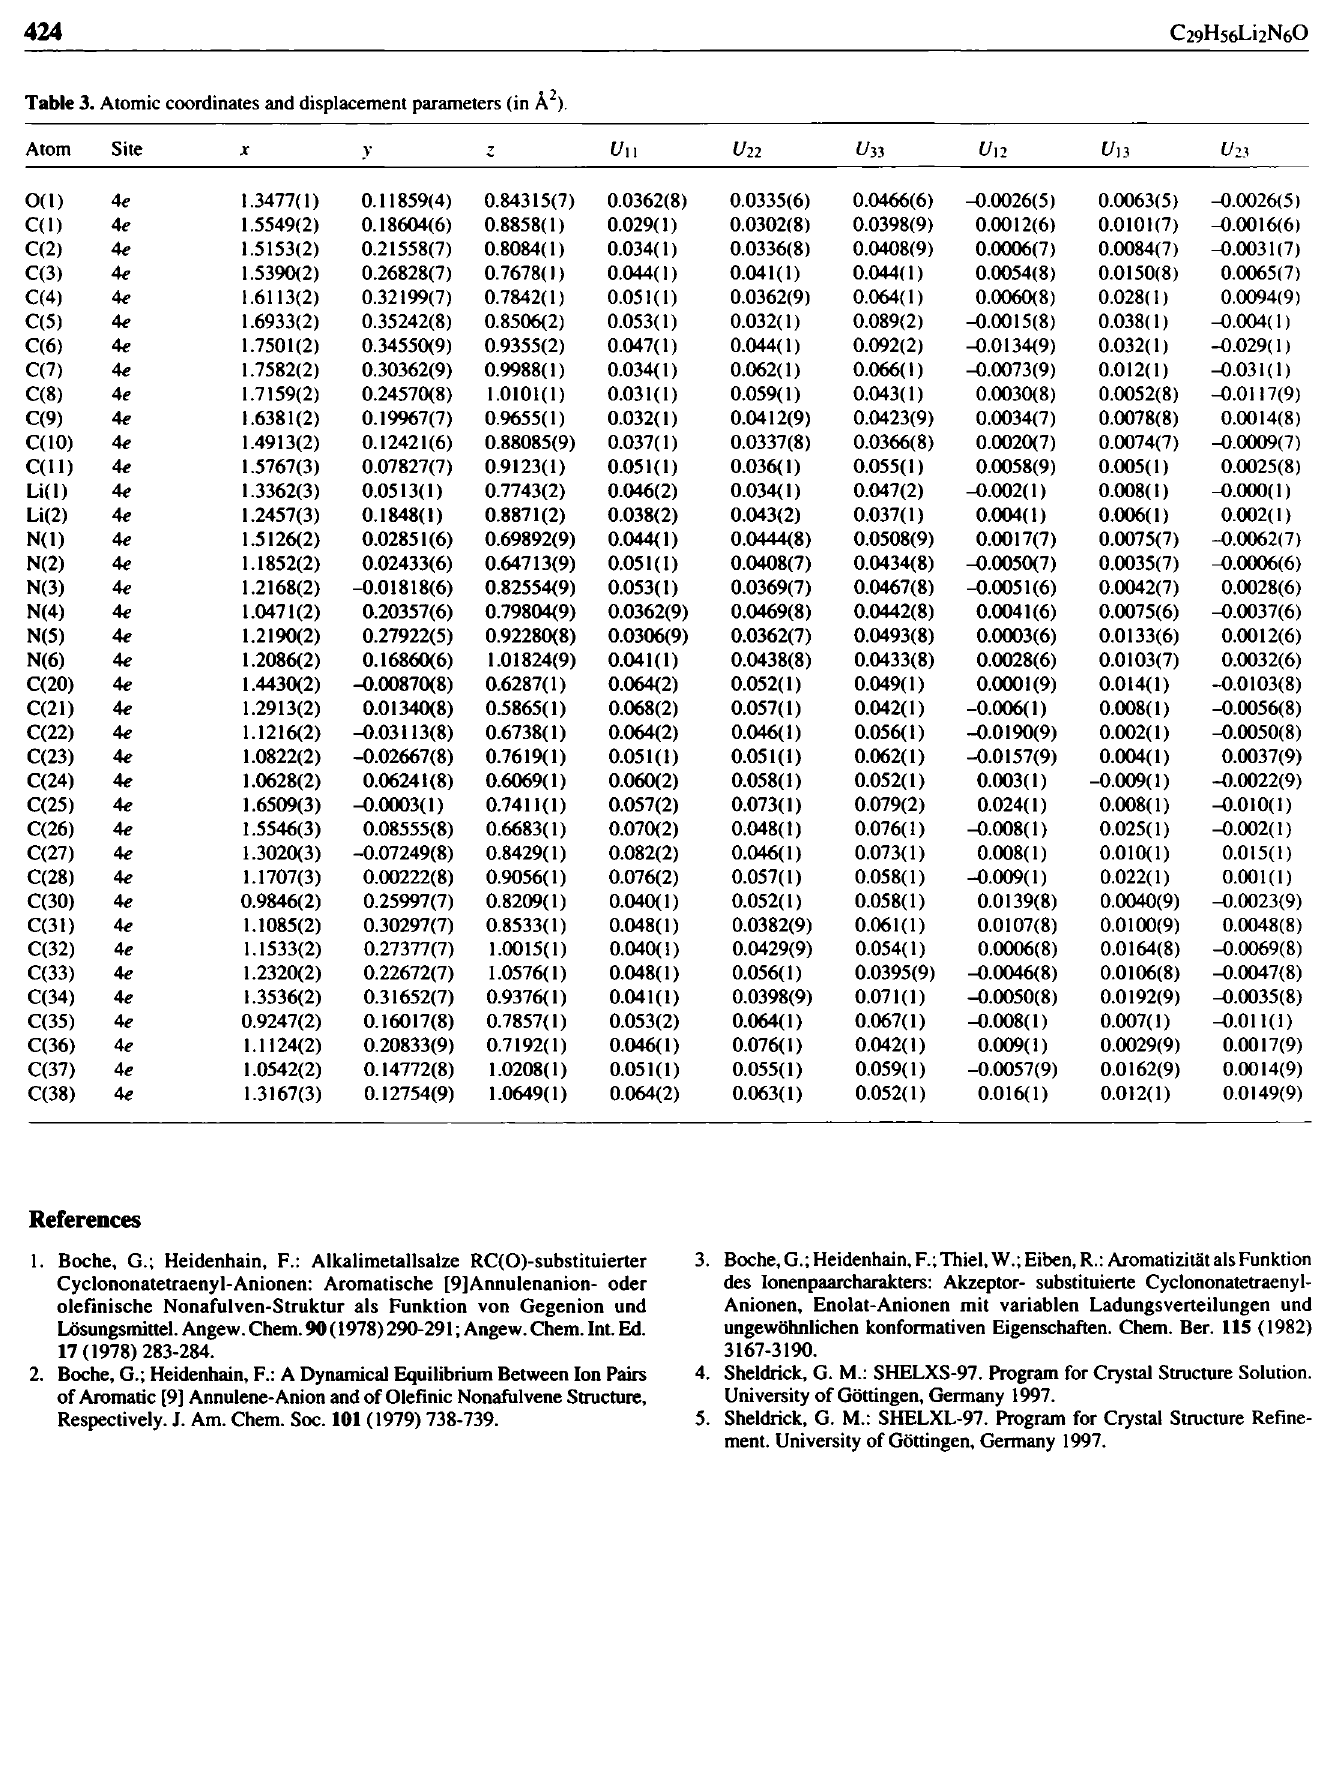
Table 3. Atomic coordinates and displacement parameters (in A 2